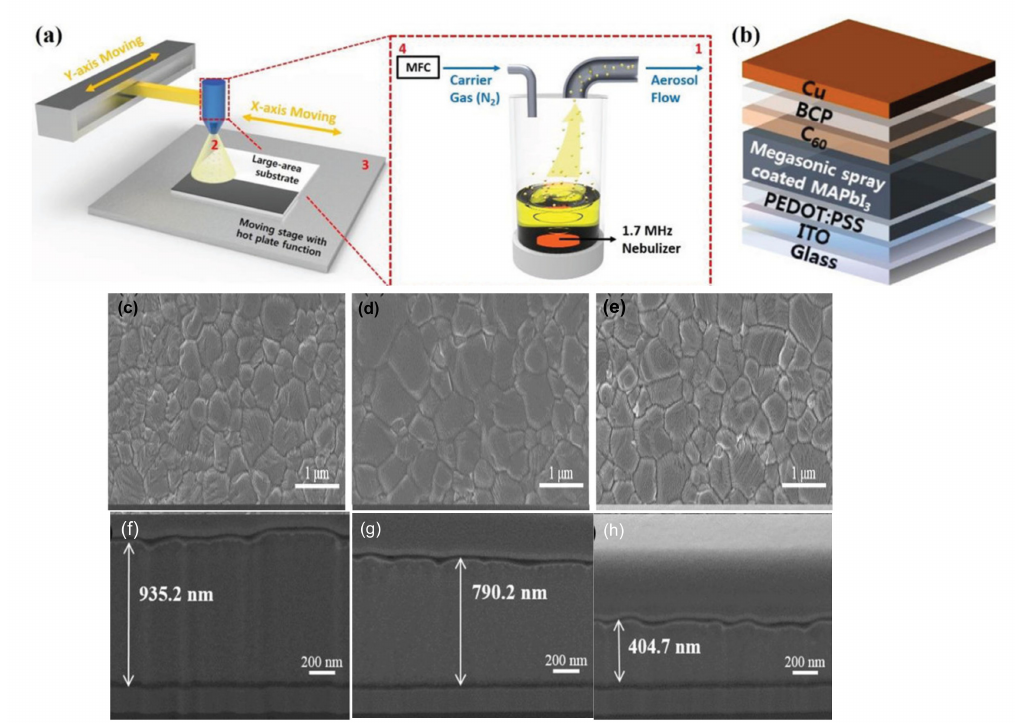
Figure 11. ( a ) Represents the megasonic spray coating process. ( b ) Represents the inverted planar MAPbI 3 PSC fabricated by the megasonic spray coating system. ( c – h ) Surface and FIB-cross-section SEM images of the perovskite film coated on glass / ITO / PEDOT:PSS with scan speed: ( c , f ) 10 mm s − 1 , ( d , g ) 15 mm s − 1 , and ( e , h ) 20 mm s − 1 . The films were annealed at 120 ◦ C for 1 min with DMSO